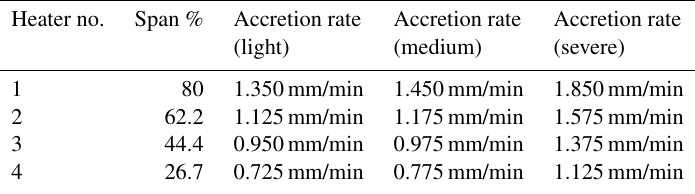
Table 2. Ice accretion rates (mm/min) for each heater zone.